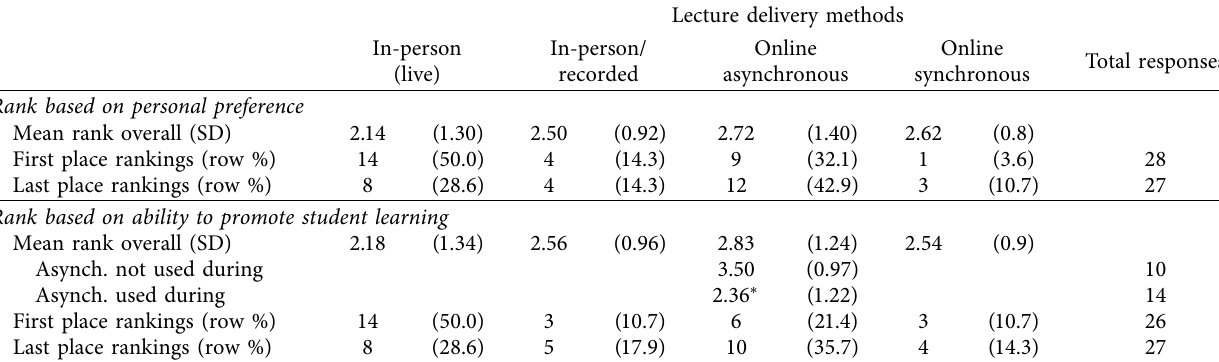
Table 2: Detroit Mercy dental faculty ranked (1–4) in-person lecture methods in comparison with remote instruction lecture methods based on personal preference and on their ability to promote student learning.